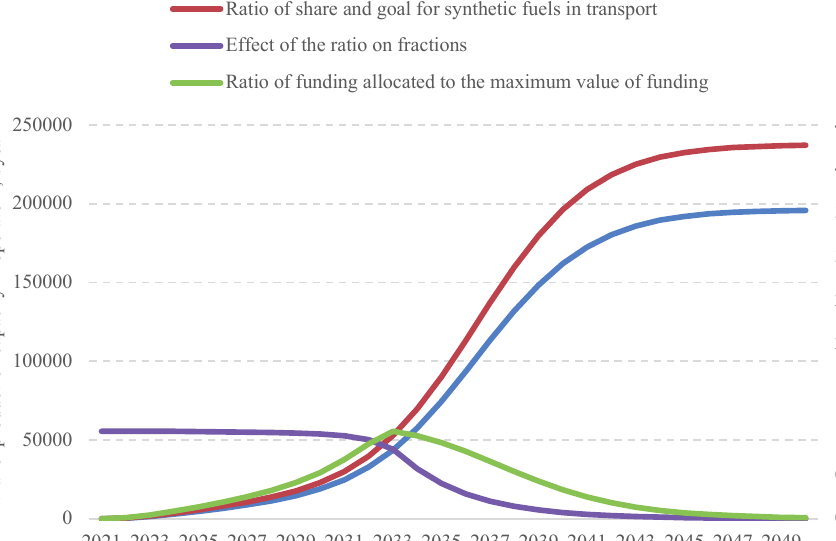
Fig. 4. Graph illustrating dynamics of the ethanol production capacity in operation (left-hand axis), ratio of the actual share and the goal of synthetic fuels in transport (right-hand axis), effect of this ratio on fraction of avoided CO 2 emission costs which are allocated to funding of R&D and ethanol production subsidies (right-hand axis) as well as ratio of the funding allocated to R&D and ethanol production subsidies to the maximum value of the funding allocated (right-hand